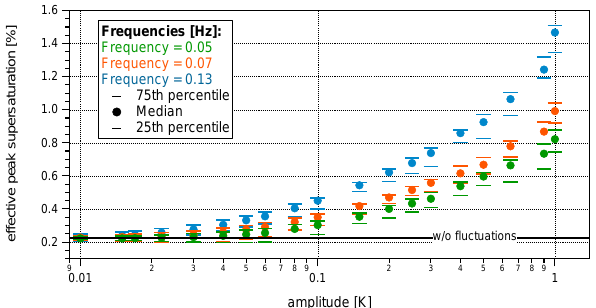
Figure 12. Modelled effective peak supersaturations applying sim- ulated small-scale fluctuations (SS fluc,sin obtained with a sinus ) to the peak peak function using an amplitude A = 0 . 022K and a frequency f = 0 . 24s − 1 ) to the cooling rate vs. the one applying small-scale fluc- tuations obtained from the ultrasonic anemometer measurements (SS fluc ). The black line indicates the 1 : 1 line and the red line peak shows the linear